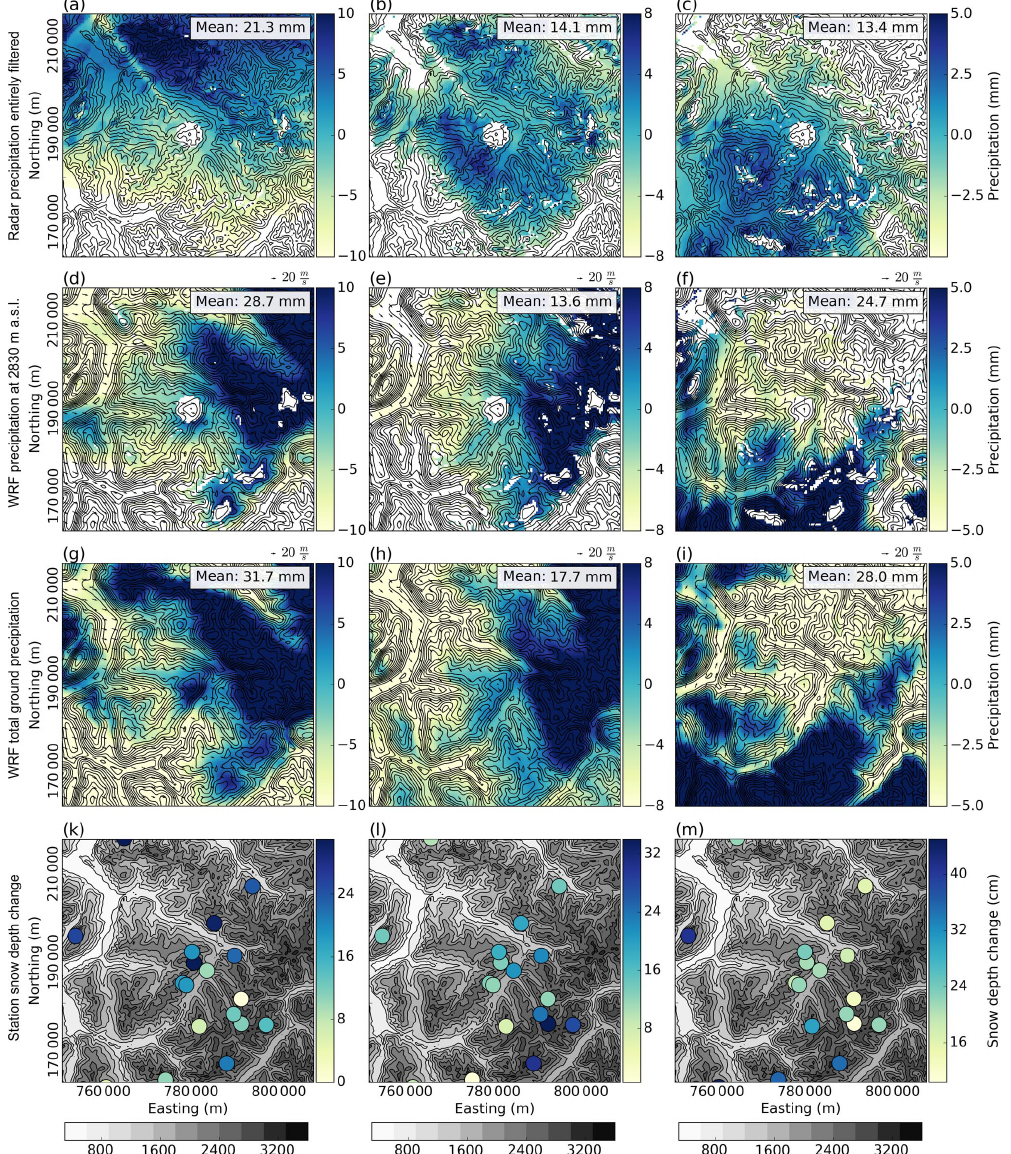
Figure 4. The 24h snow precipitation (mm) from (a–c) MeteoSwiss entirely filtered radar measurements, (d–f) Weather Research and Forecasting (WRF) snow precipitation at 2830m above sea level (ma.s.l.), (g–i) WRF total ground precipitation and (k–m) 24h snow depth changes (cm) at meteorological stations on 31 January 2016 (left), 4 February 2016 (middle) and 5 March 2016 (right) with a resolution of 450m in the regional domain (Fig. 1). Radar precipitation is estimated from different radar elevations (Sect. 2.3). White areas in (a– f) mark areas where clutter is removed and small values in the radar data are masked. The same mask is applied for WRF solid precipitation at 2830ma.s.l. (approximate elevation of the radar), (d–f) , for which additional areas where WRF topography is higher than 2830ma.s.l. are masked. Arrows in (d–f) indicate wind direction and speed at an elevation of 2830ma.s.l. Northing and easting are given in the swiss coordinate system (CH1903LV03). Note the different color bars. Contour lines in (a–c) and (k–m) : dhm25 ©2018 swisstopo (5740000000). Gray shading in (k–m) represents